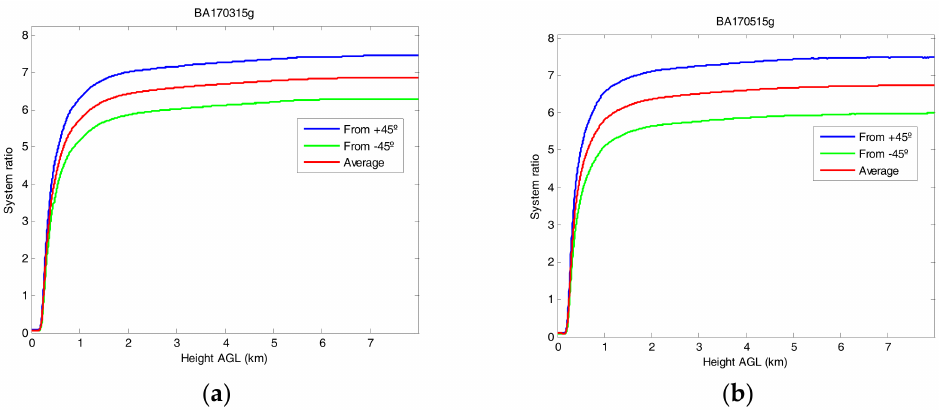
Figure 2. Profiles of 2 δ ∗ ( ϕ 0 − 45 ◦ , R ) (green), 2 δ ∗ ( ϕ 0 + 45 ◦ , R ) (blue) and V ∗ ( R ) (red) for calibrations performed on ( a ) 15 March 2017 and ( b ) 15 May